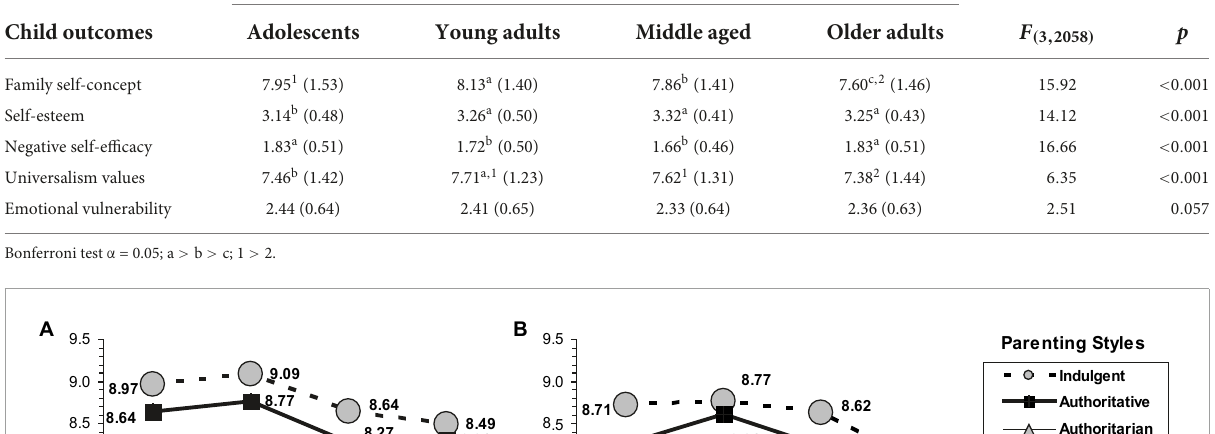
TABLE 5 Means, standard deviations, univariate F -values, and Bonferroni’s post-hoc analysis for self (family self-concept, self-esteem, and negative self-adequacy), universalism values, and emotional vulnerability by age groups.